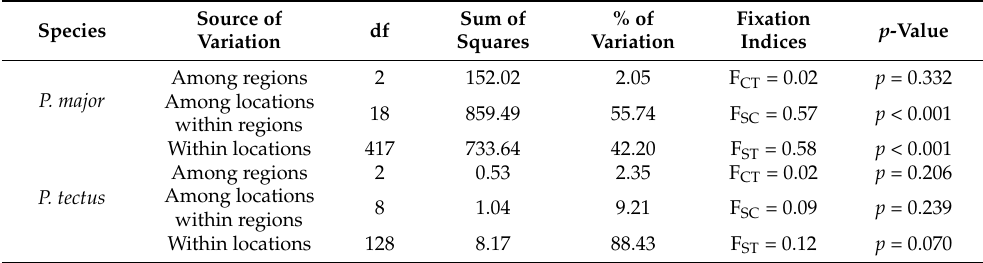
Table 8. Analysis of molecular variance (AMOVA) of COI gene sequences in di ff erent geographic regions of P. major and P. tectus .